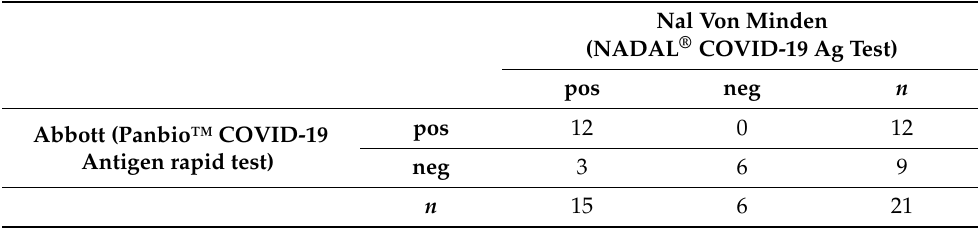
Table 1. Head-to-head comparison of two POCTs for detection of SARS-CoV-2 antigen.